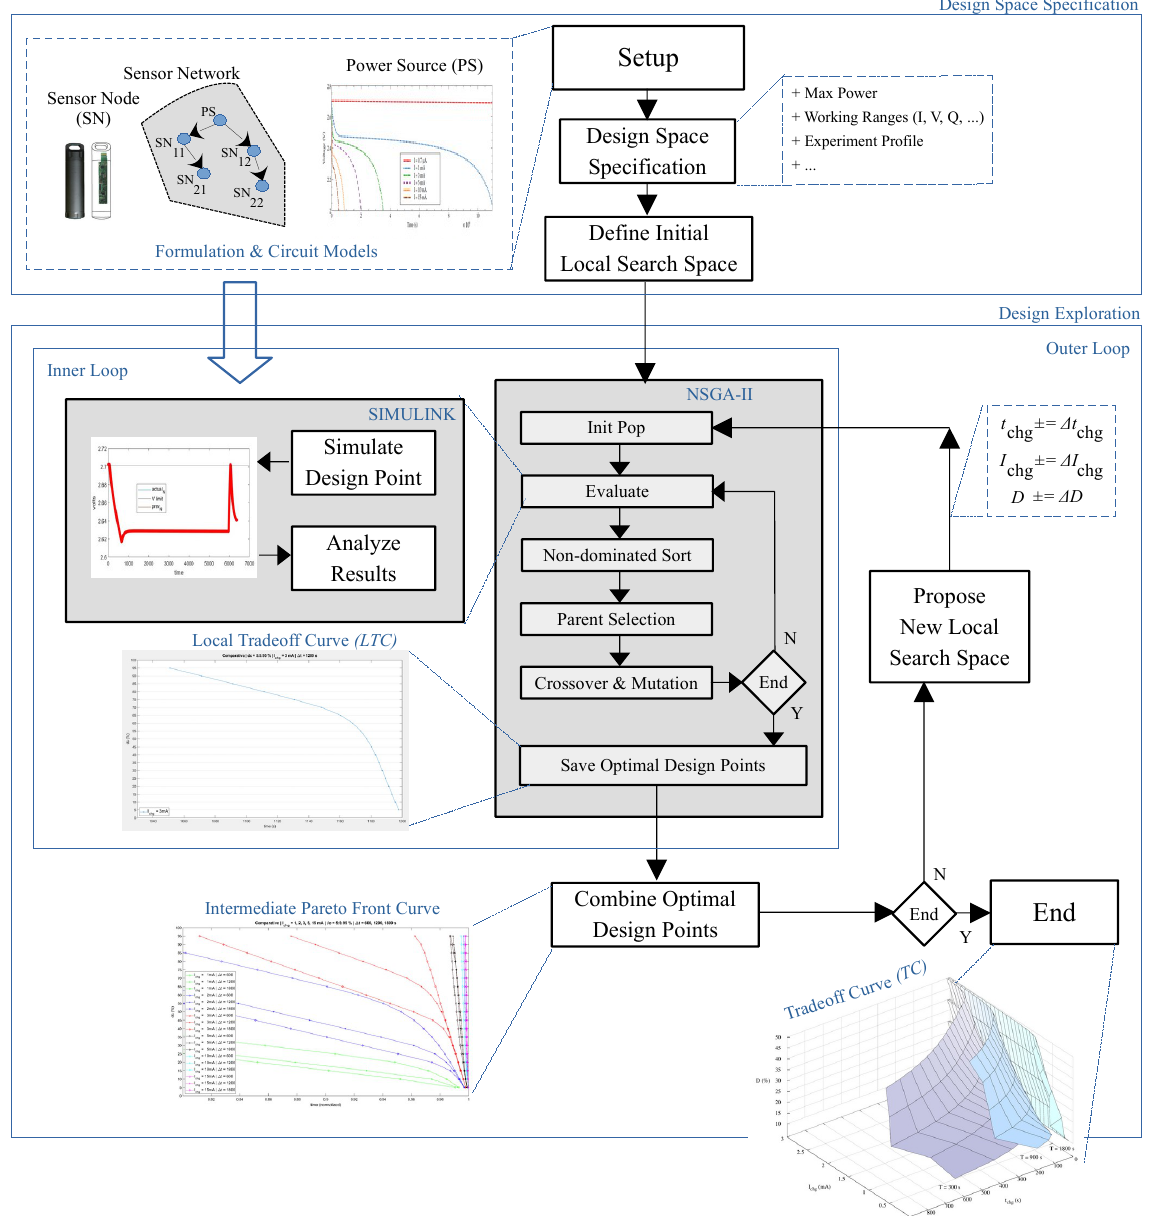
Figure 3. Proposed design space exploration